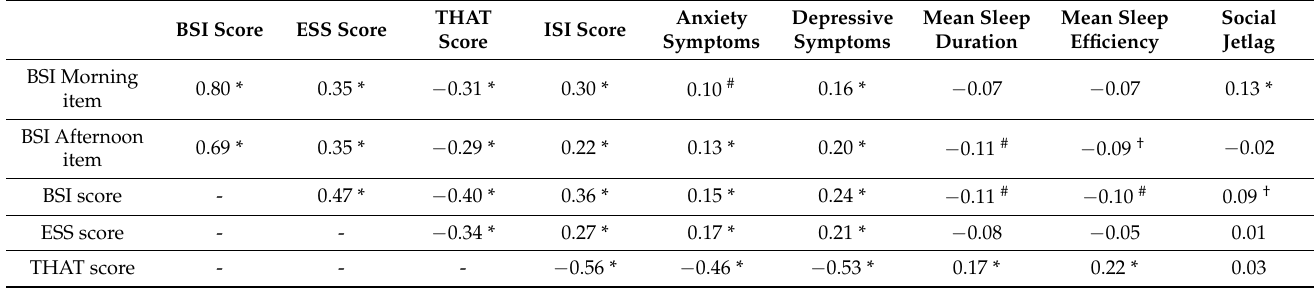
Table 4. Correlations of BSI score (and each item on the scale) with sleep outcomes ( n =